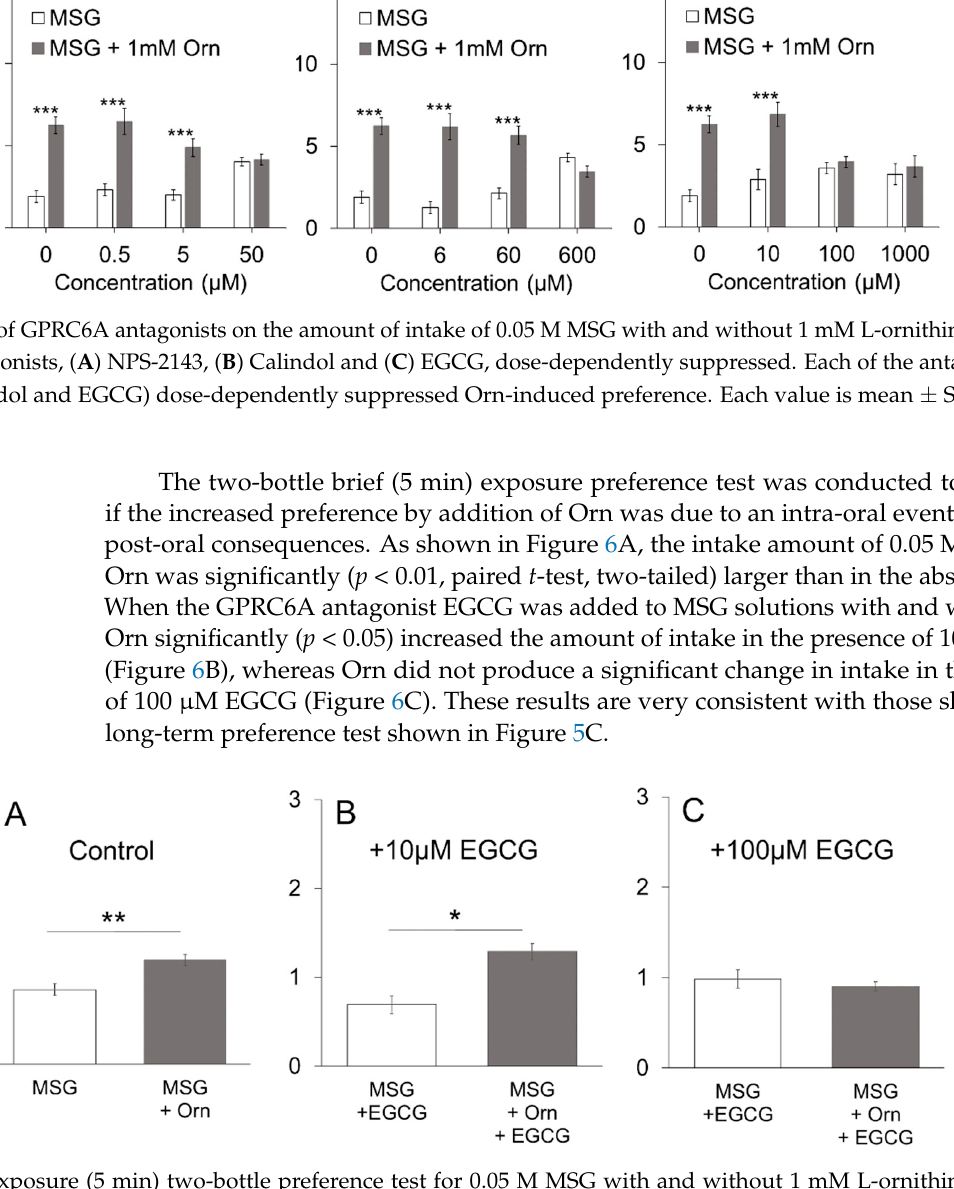
Figure 6. Brief-exposure (5 min) two-bottle preference test for 0.05 M MSG with and without 1 mM L-ornithine (Orn) and effects of EGCG. Intake of MSG increased by addition of Orn in the absence of the GPRC6A antagonist ( A ), or in the presence of 10 µ M EGCG ( B ), 100 µ M EGCG ( C ); however, the effect of Orn was blocked in the presence of 100 µ M EGCG. Each value is mean ± SE; n = 8. * p < 0.05, ** p < 0.01.